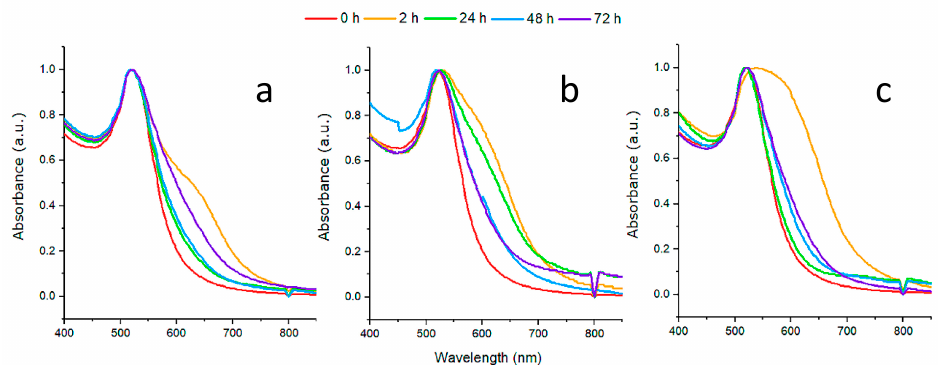
Figure 2. Ultraviolet-visible spectra for: ( a ) Gold nanoparticles (AuNPs)-ALA, ( b ) AuNPs-MAN, and ( c ) hydrazinonicotinamide-glycine-glycine-cysteine (HYNIC)-AuNPs-MAN. The red color indicates the spectra of pristine gold nanoparticles and the yellow, green, blue, and purple colors indicate the incubation times at 2, 24, 48, and 72 h, respectively.